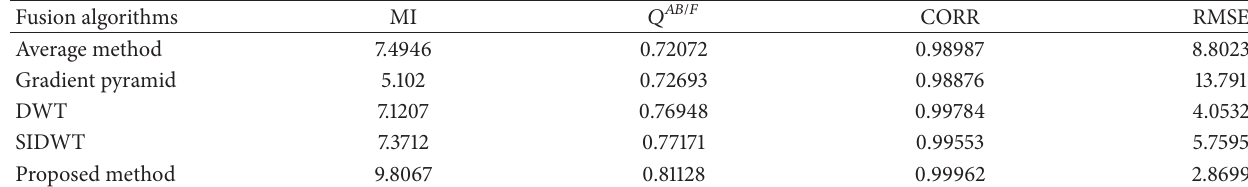
Table 1: Performance comparison of different fusion algorithms in Figure 4.